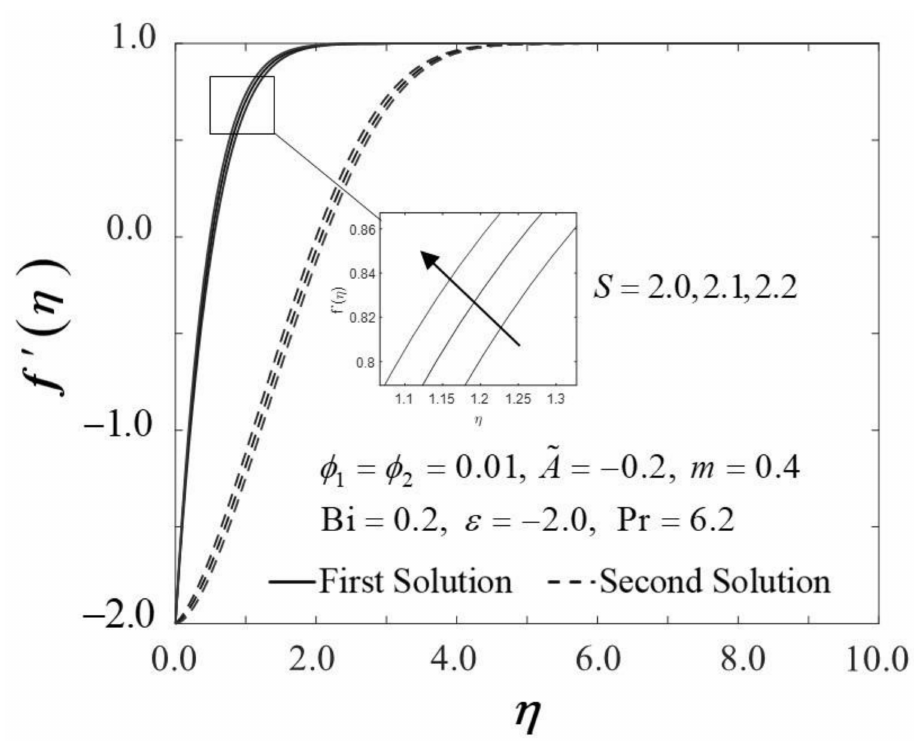
Figure 12. Trend of f (cid:48) ( η ) with η and assorted S